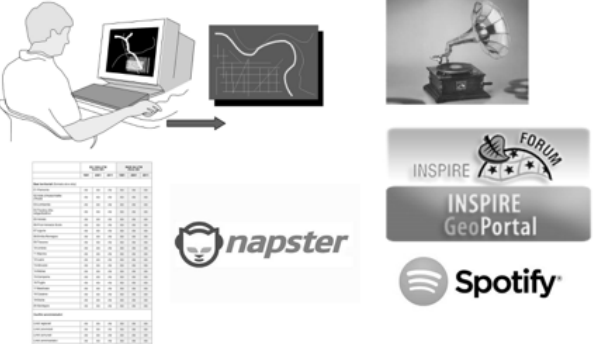
Figure 1. Parallelism between the different approaches that characterize the various eras of geographic information and music (Murgante,